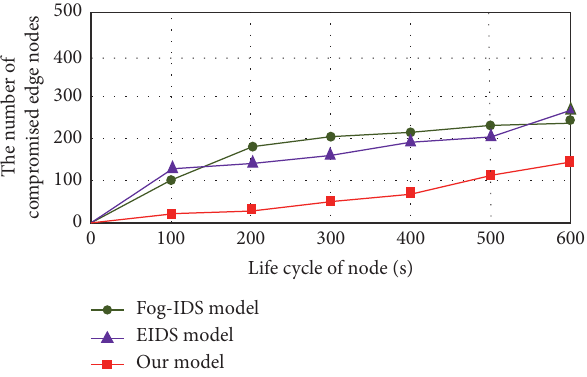
Figure 10: The number of compromised nodes under ( τ , υ ) � ( 0 . 3 , 0 . 5 )